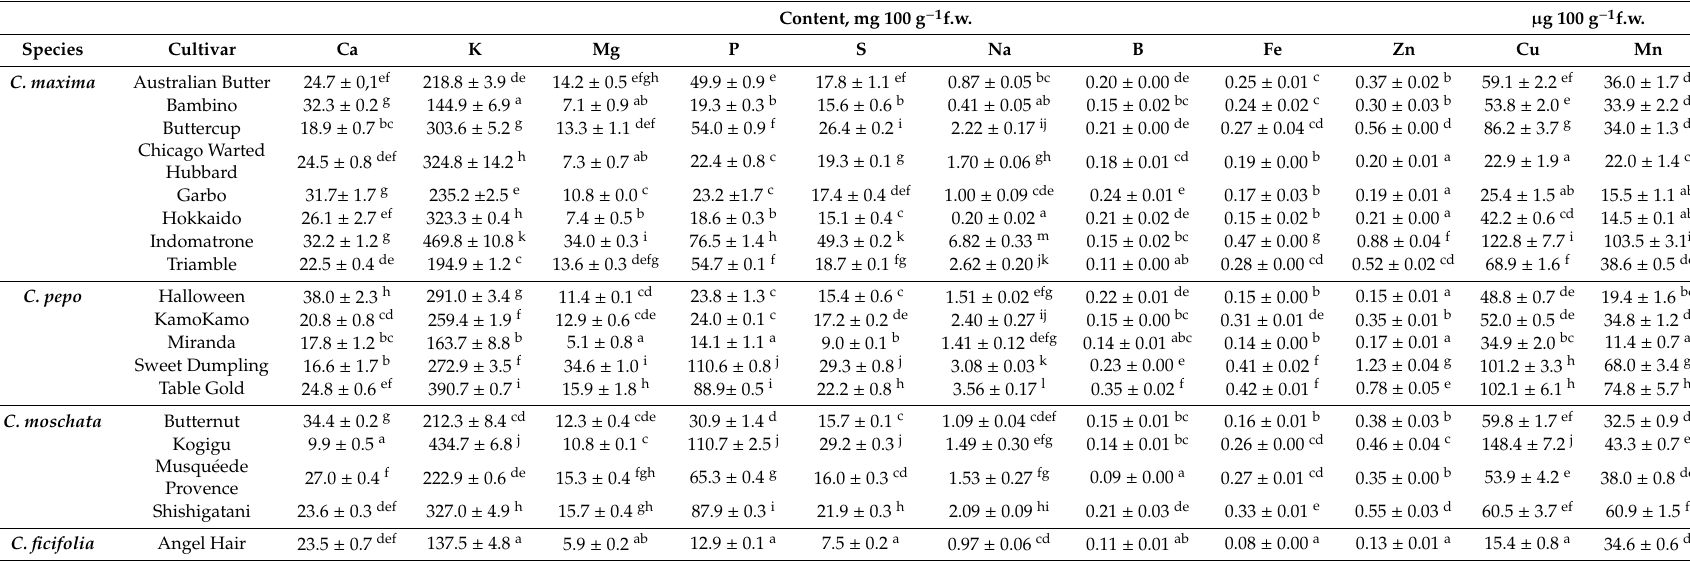
Table 4. Content of selected macro- and micronutrients in the pulp of 18 Cucurbita cultivars. Content, mg 100 g − 1 f.w. µ g 100 g − 1